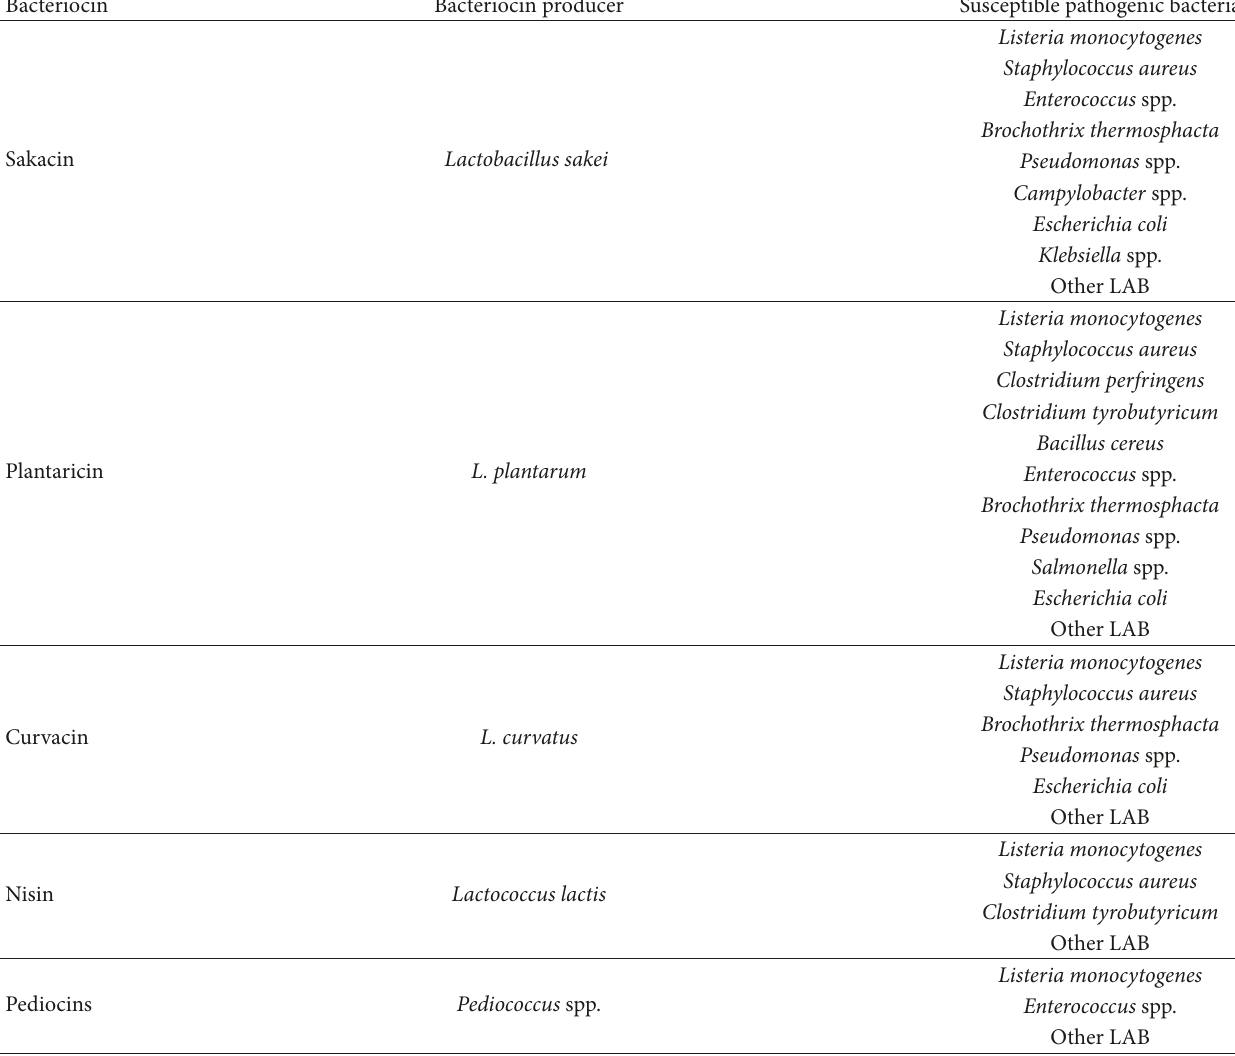
Table 4: LAB bacteriocins, bacteriocin producers, and susceptible pathogenic